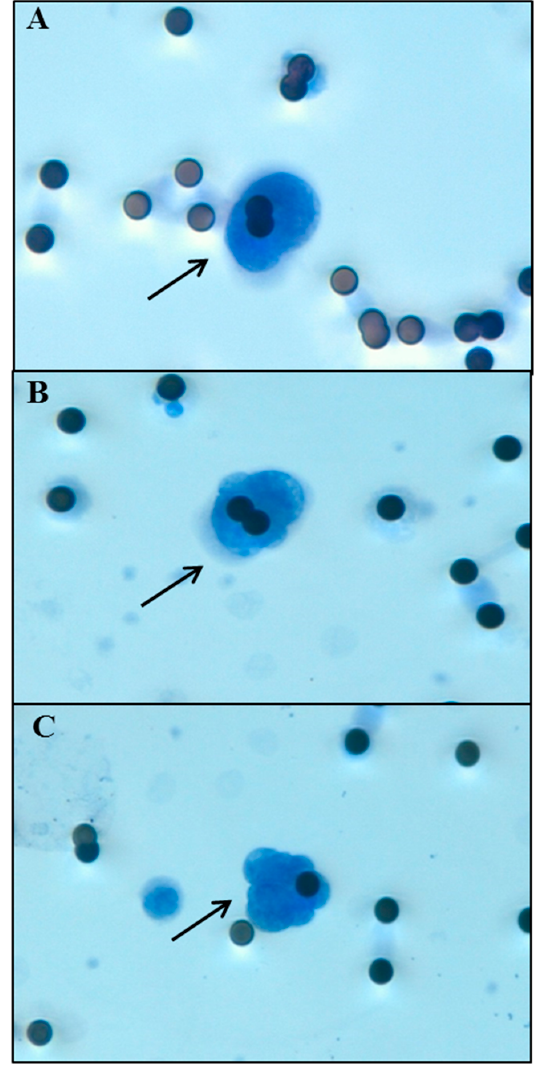
Figure 3. Morphological analysis of NSCLC cells entrapped on a ScreenCell Cyto device filter. The black arrows indicate non-hematologic circulating cells with malignant features. ( A ) Adenocarcinoma (H&E staining, magnification 40×); ( B ) Squamous cell carcinoma (H&E staining, magnification 40×); ( C ) Microemboli (H&E staining, magnification 40×). Micropores dimension: 7.5 ± 0.36 μ m.